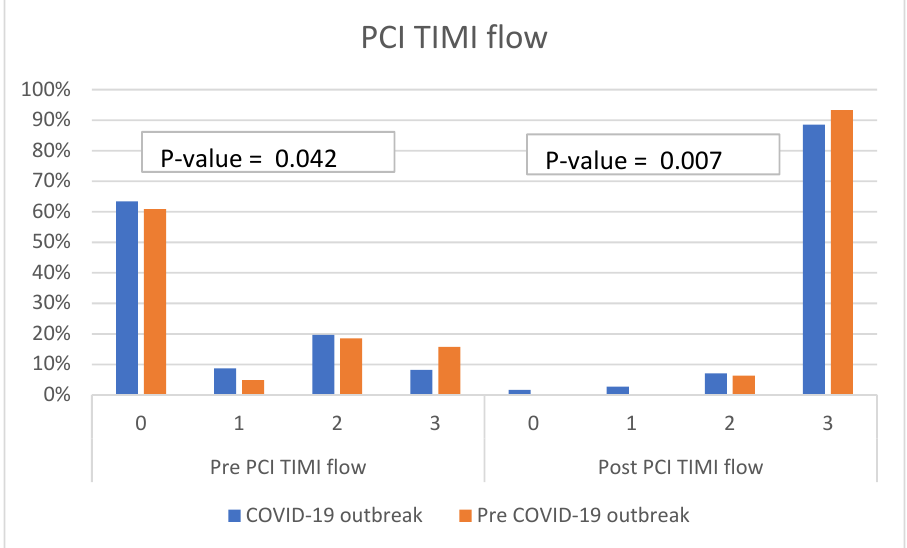
Figure 2. The bar charts compared the pre- and post-PCI TIMI flow between the pre-COVID-19 period and during the COVID-19 outbreak.